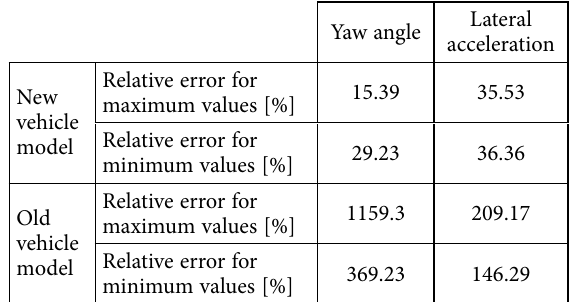
Fig. 12 sketches tire’s vertical forces of the model: